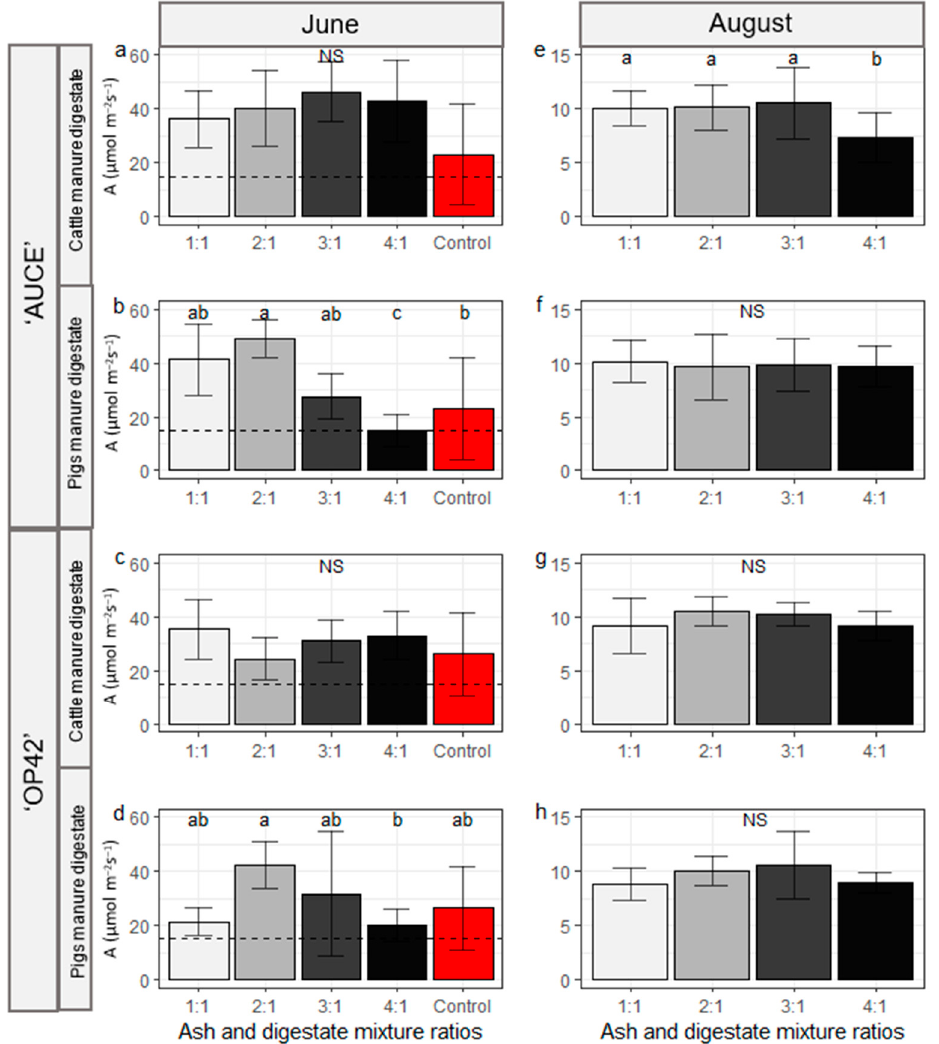
Figure 6. A (Leaf photosynthetic rate) in June ( a – d ) and August ( e – h ) for poplar clones ‘AUCE’ ( a , b , e , f ) and ‘OP42’ ( c , d , g , h ) fertilised with cattle ( a , e , c , g ) or pig ( b , f , d , h ) manure digestate depending on the different ratio of the wood ash and digestate mixtures. For June and August plots, different y -axis length was chosen to better represent differences in both months. The maximum of the y -axis scale differs between months and the black dashed line in June plots represents y axis length in August plots. Letters represent significant differences ( p < 0.05, pairwise Wilcox test). The population standard deviation is represented with error bars.